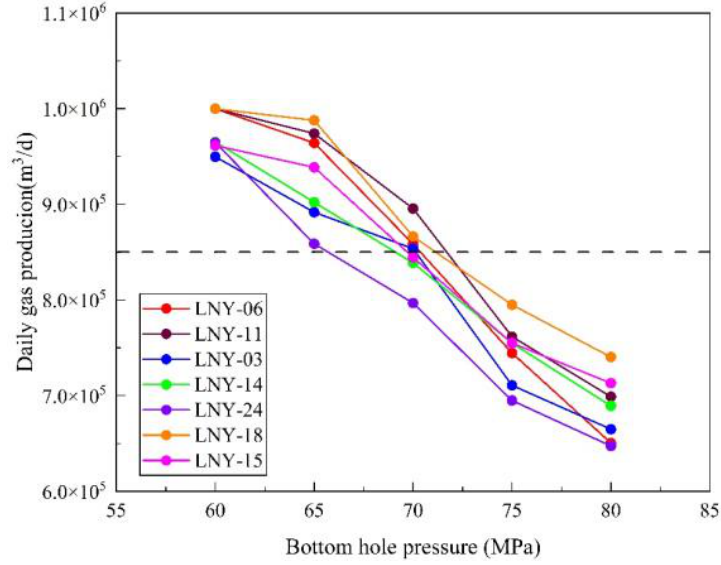
Figure 22. Daily gas production of seven